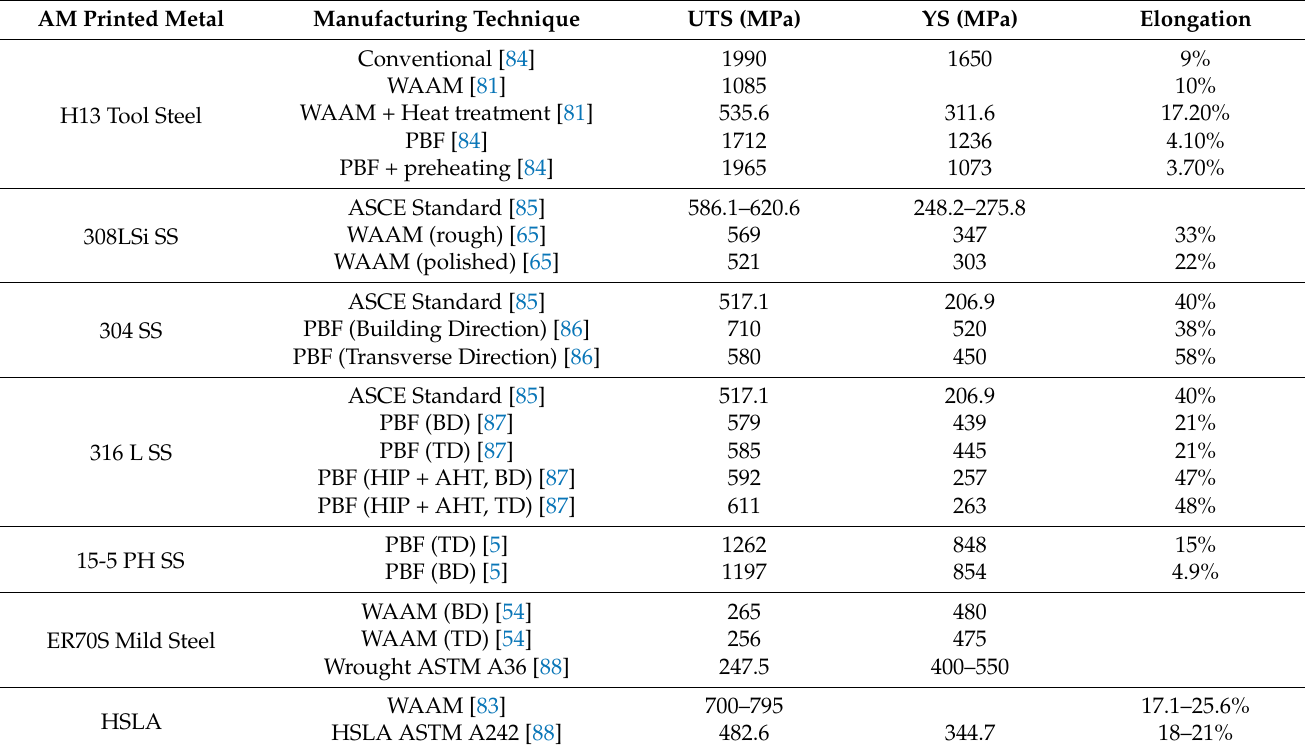
Table 1. Mechanical properties of metallic AM